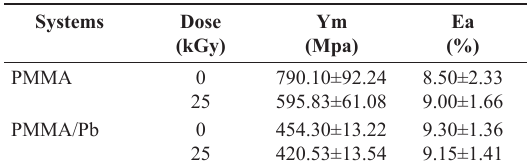
Table 3. Effects of PbS-NP and gamma irradiation in mechanical properties of